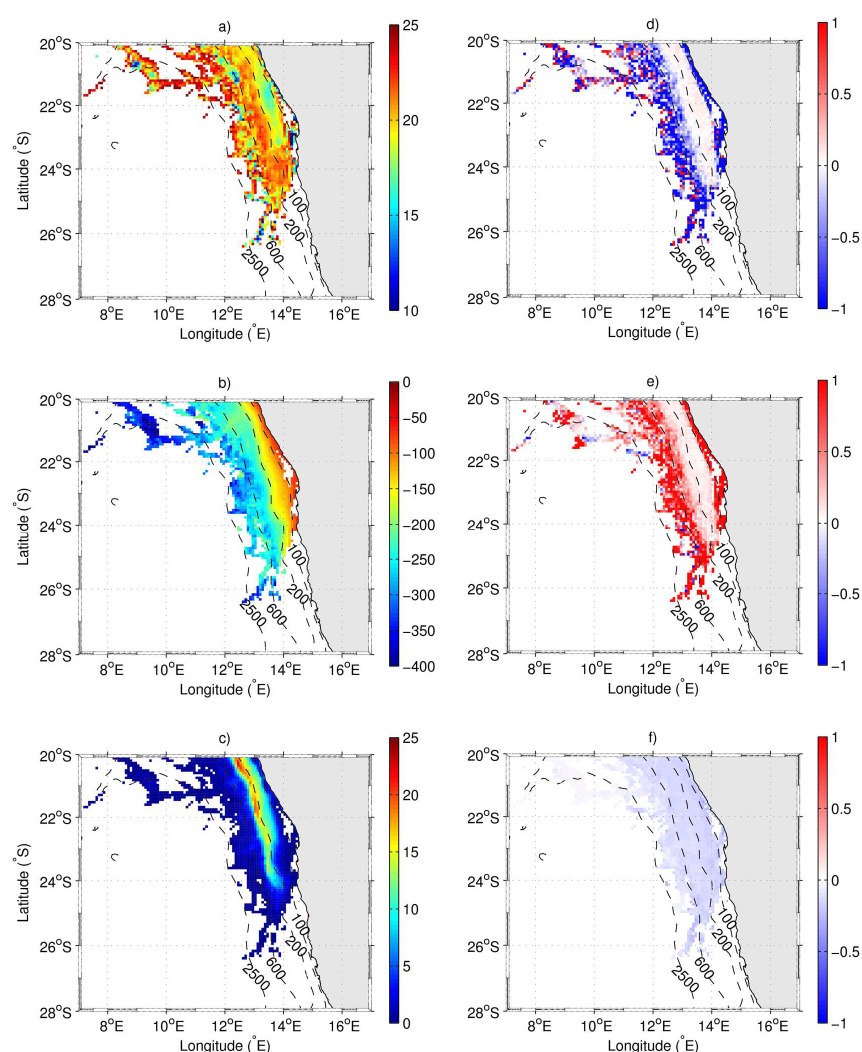
Fig. 14. (a) Minimum oxygen concentrations (mmolO 2 m − 3 ) simulated in the OMZ, (b) depth (m) of these minimum oxygen concentrations, (c) thickness (m) of the OMZ, (d) oxygen advection term (sum of zonal, meridional and vertical components;mmol O 2 m − 3 d − 1 ;), (e) oxygen mixing term (sum of horizontal and vertical components; mmolO 2 m − 3 d − 1 ) , and (f) oxygen consumption by biogeochemistry (oxic decomposition + nitrification; mmolO 2 m − 3 d − 1 ) at the depth of minimum oxygen concentration. For fluxes, negative values represent an oxygen sink and positive a source. All fields are averaged over the 8 analyzed